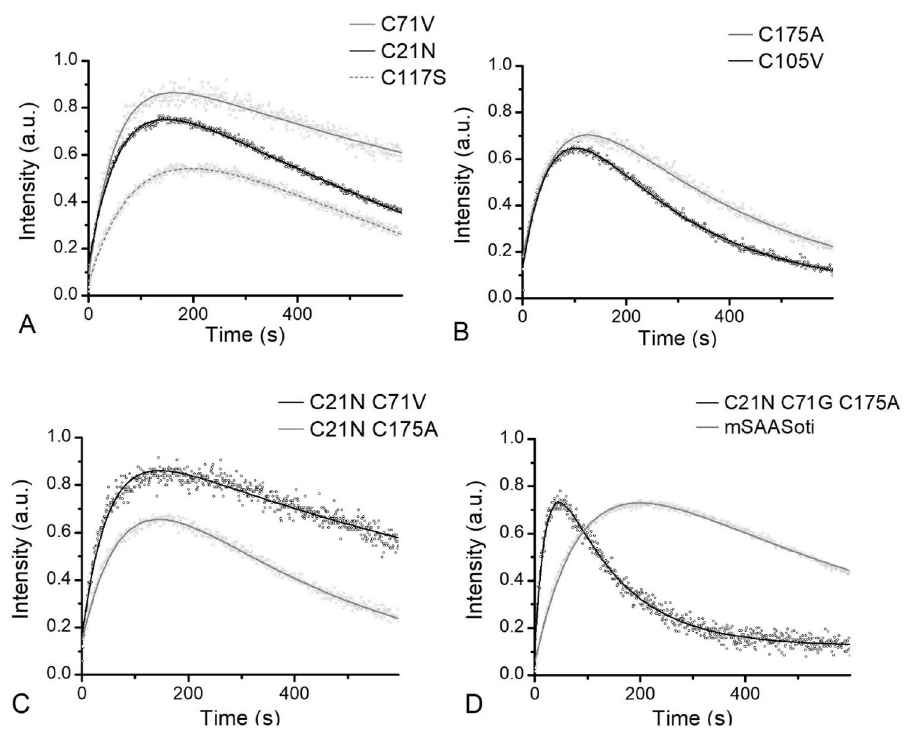
Figure 2. Green-to-red photoconversion kinetics of mSAASoti variants (λ em = 590 nm) recorded during 10 min of 400 nm (146 mW/cm 2 ) illumination. Dots—experimental data, line—fitting. Proteins with a single mutation of Cys side chains oriented: ( A ) to the solution; ( B ) inside the β-barrel; ( C ) double mutations; ( D ) triple mutation. Fluorescent intensity is normalized to pre-exponential value I according to Eq.